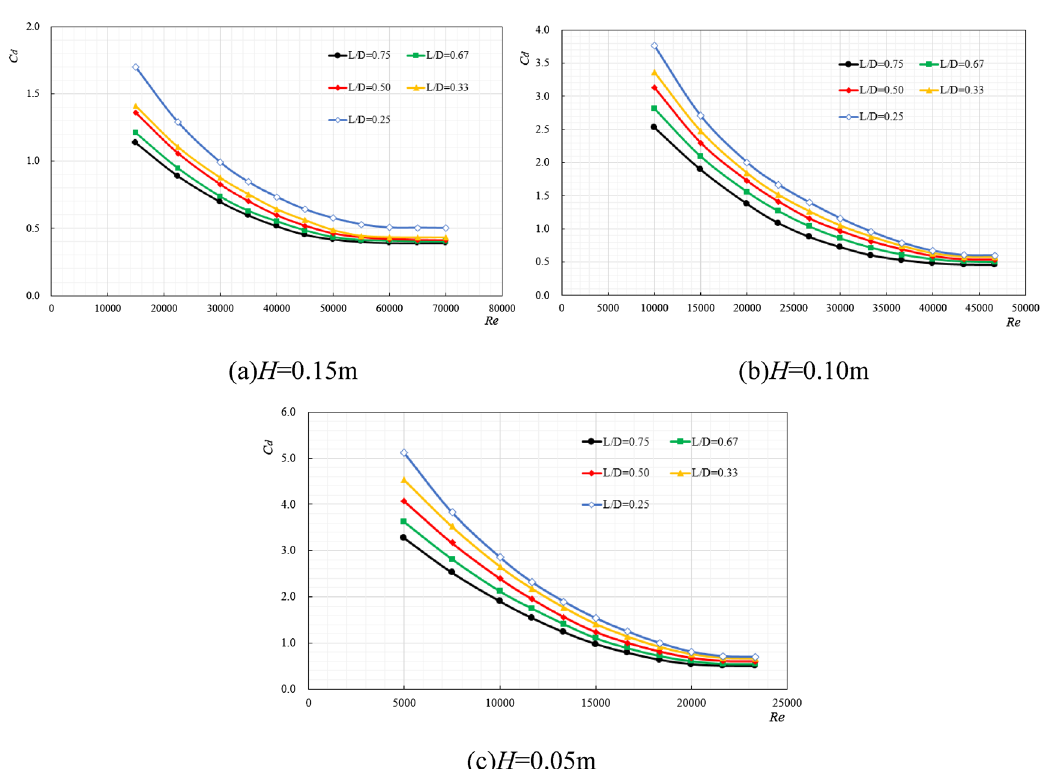
Figure 5. The variation law of resistance coefficient under different length-diameter